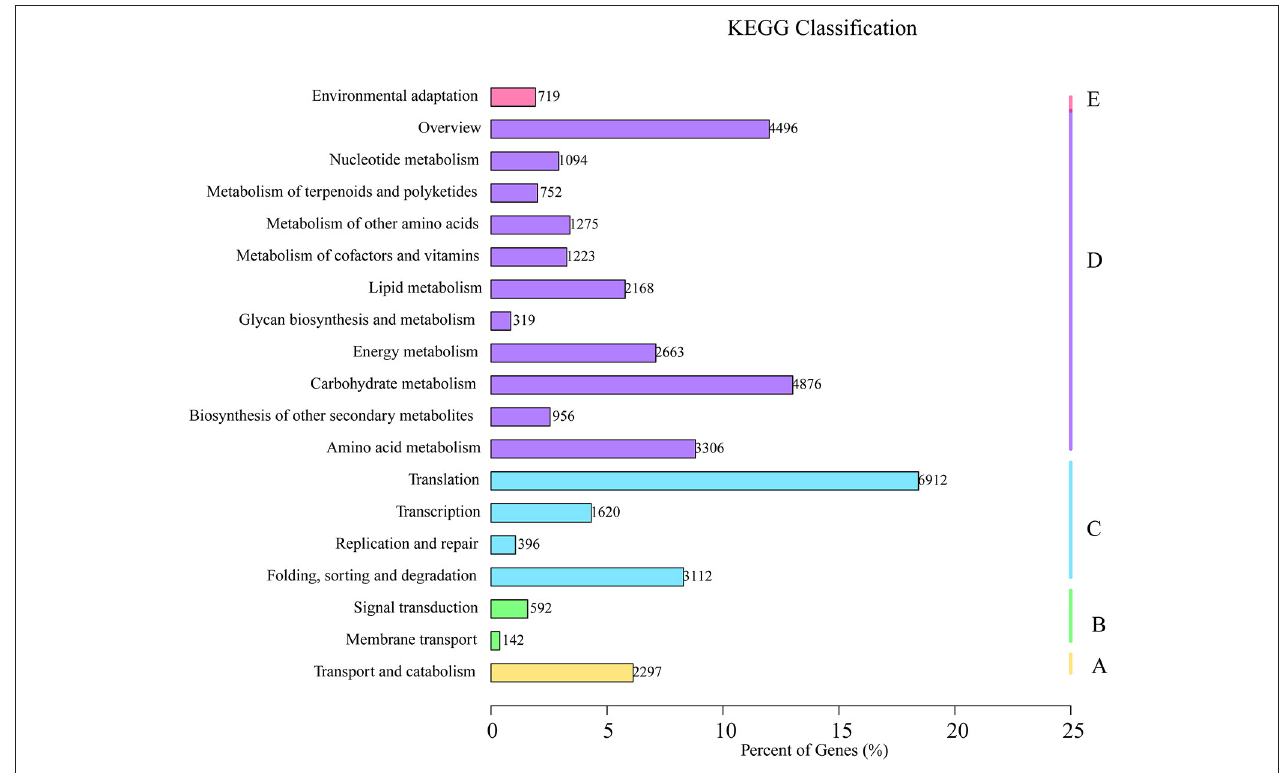
FIGURE 5 | Pathway assignment based on the Kyoto Encyclopedia of Genes and Genomes (KEGG). (A) Classification based on cellular process categories, (B) classification based on environmental information processing categories, (C) classification based on genetic information processing categories, (D) classification based on metabolism categories, and (E) classification based on organismal systems categories.